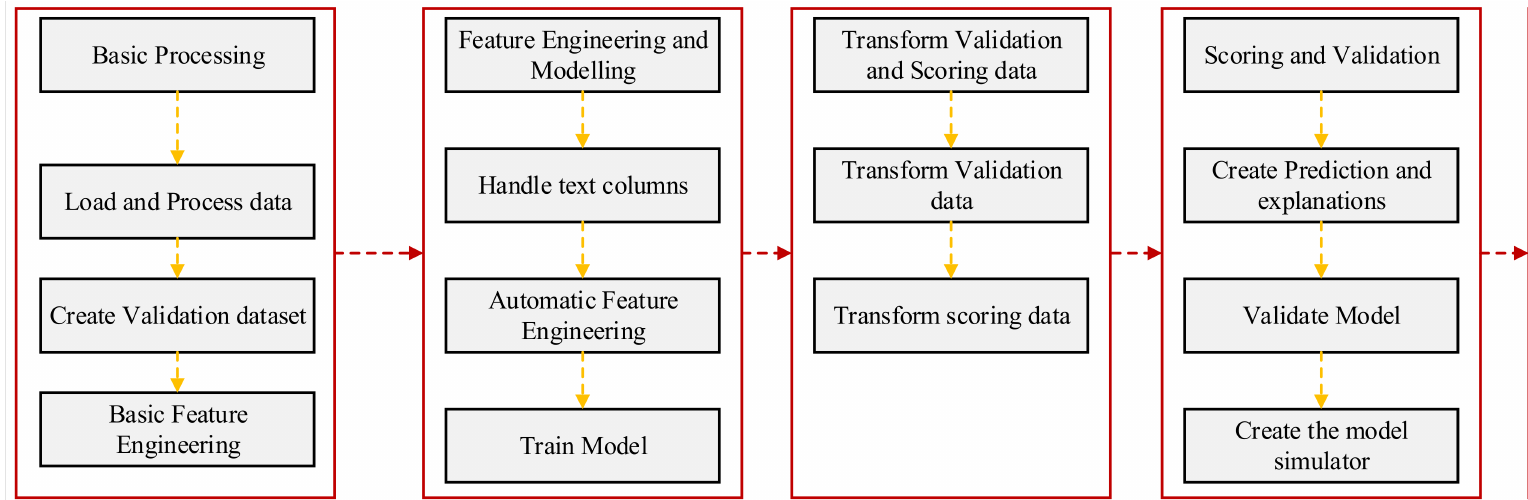
Figure 2. Development of DT and GBT